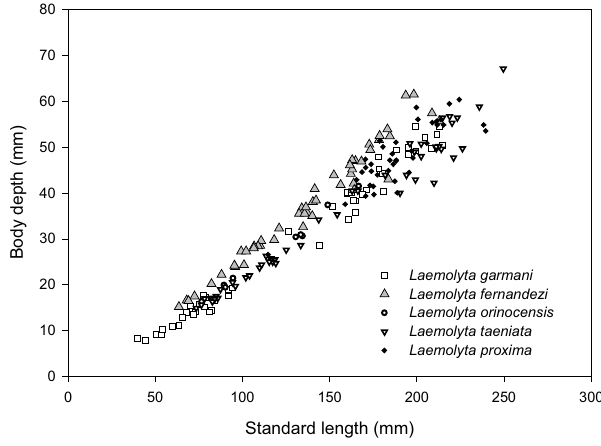
Fig. 5. Scatter plot of body depth on standard length for all species of Laemolyta .